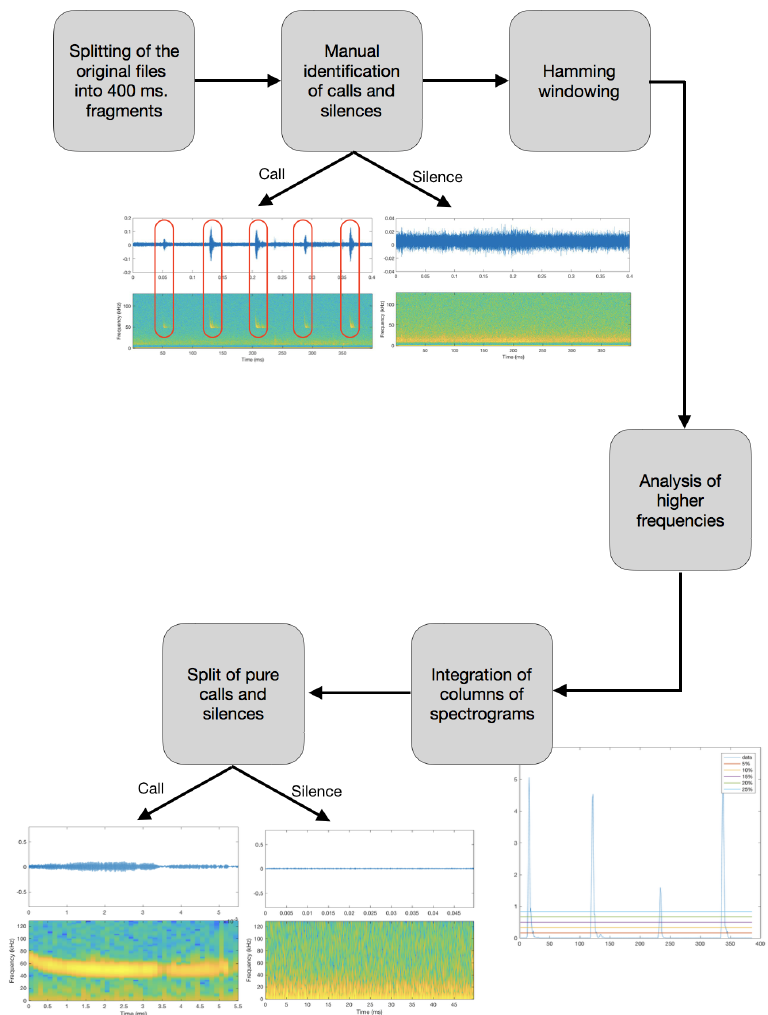
Figure 6. Diagram of the full process to analyse and segment the initial audio files into the parts that conform the final